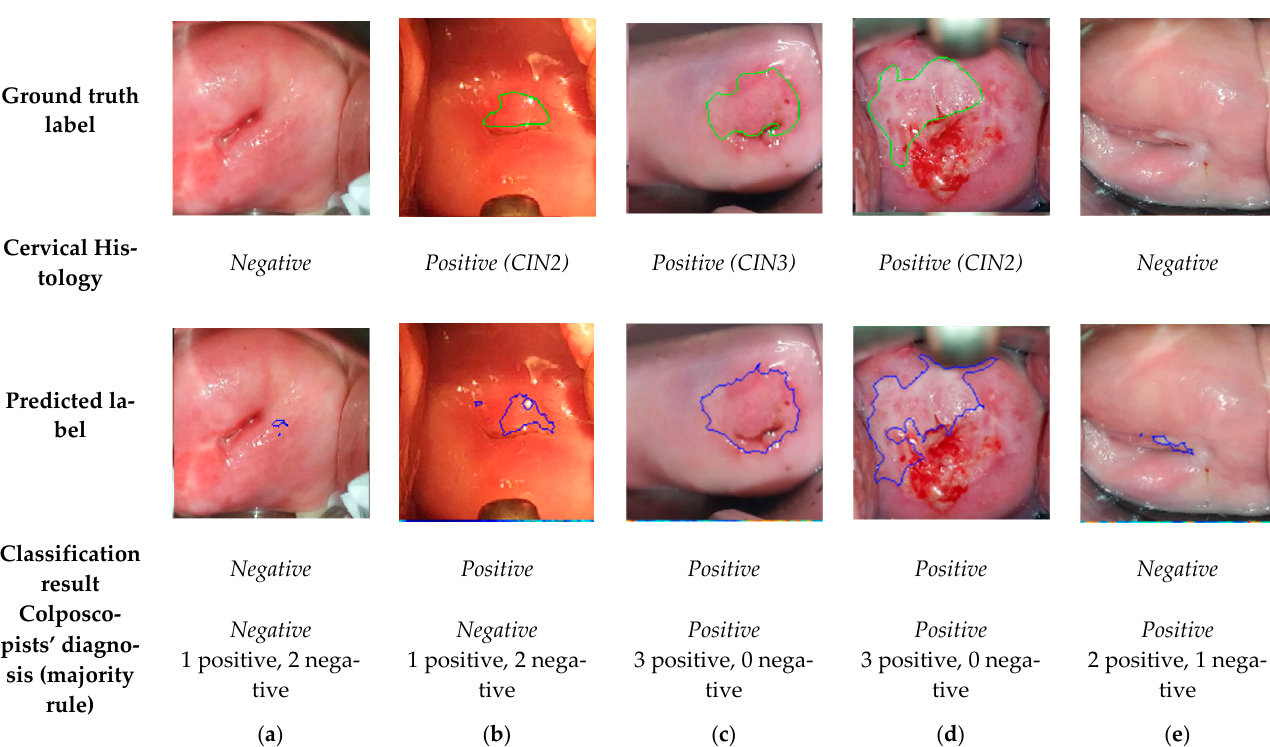
Figure 6. Frames corresponding to one minute after acetic acid application with the ground truth labels, histology results, predicted labels by the algorithm, resulting classification, and colposcopists’ diagnosis.